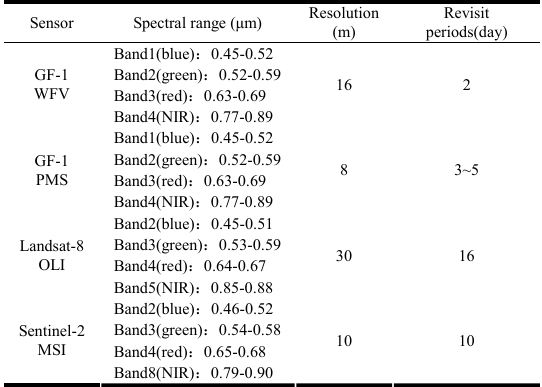
Table 1. Overview of the main parameters of the multiple sensors